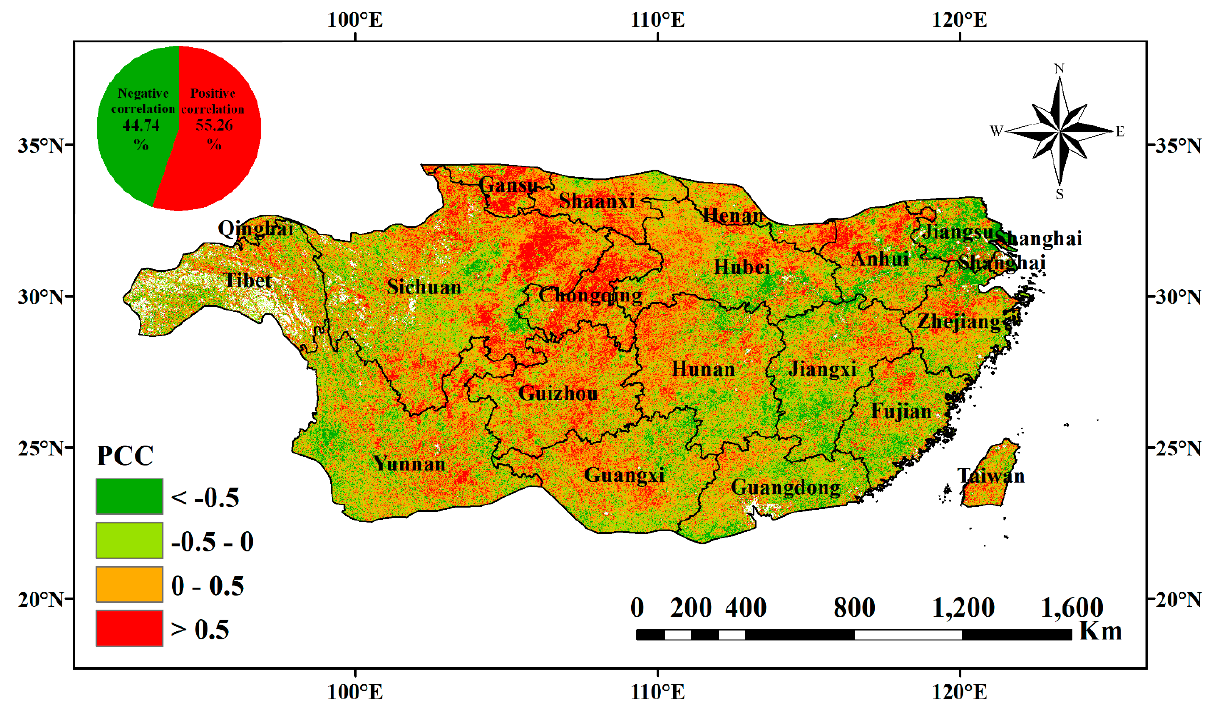
Figure 7. Spatial distribution of PCC values between the subtropical FVC and Pre from 2001 to 2018.